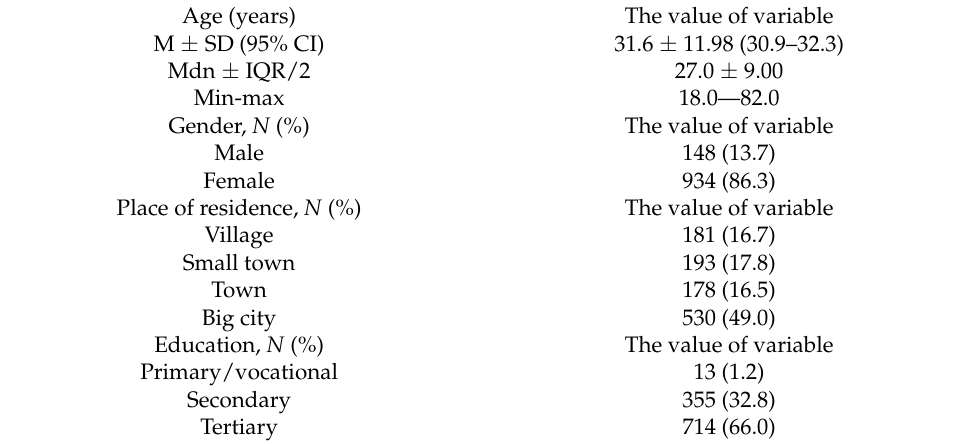
Table 2. Characteristics of the study group ( N =